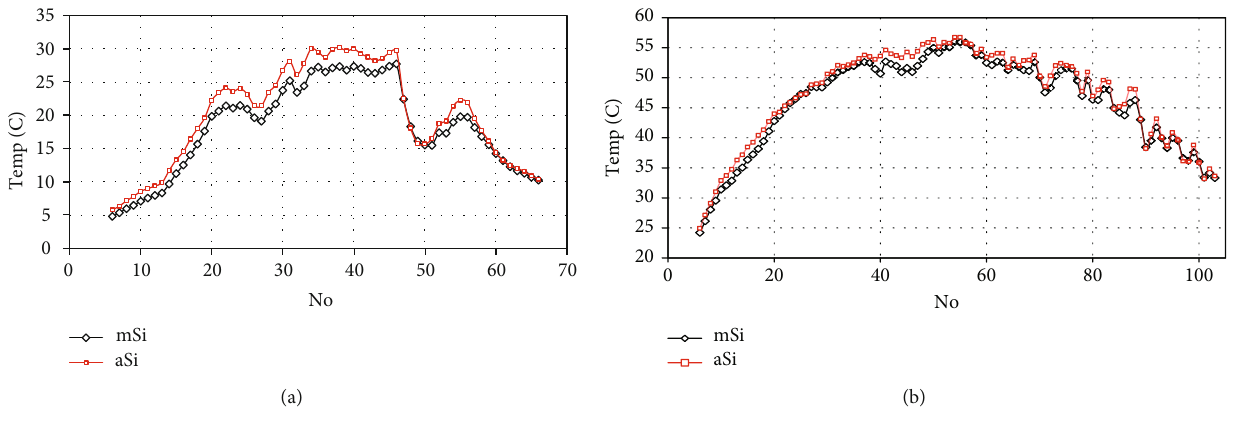
Figure 7: The temperature of the two photovoltaic panels: (a) winter day and (b) summer